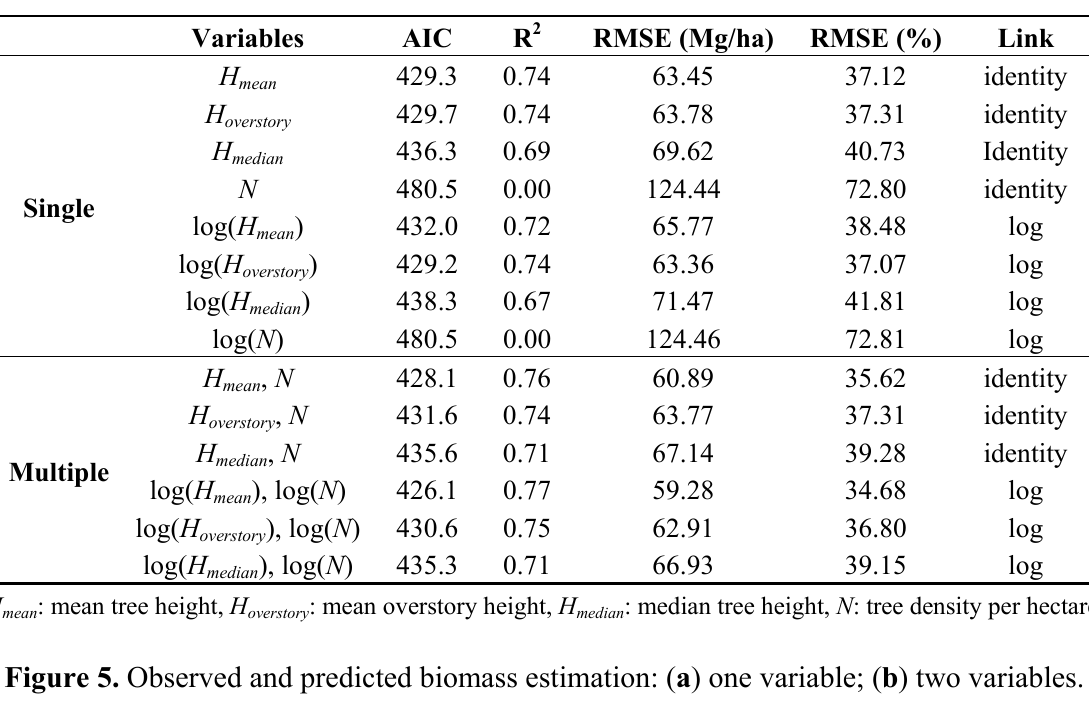
Table 2. Results of regression analysis for biomass estimation model.